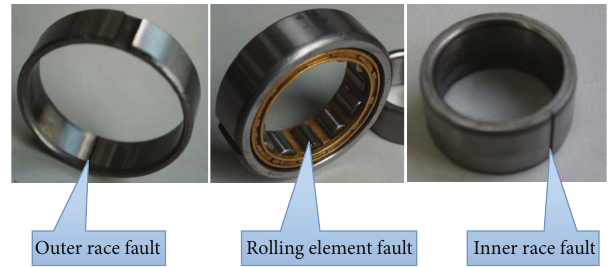
Figure 5: Rolling bearing fault.